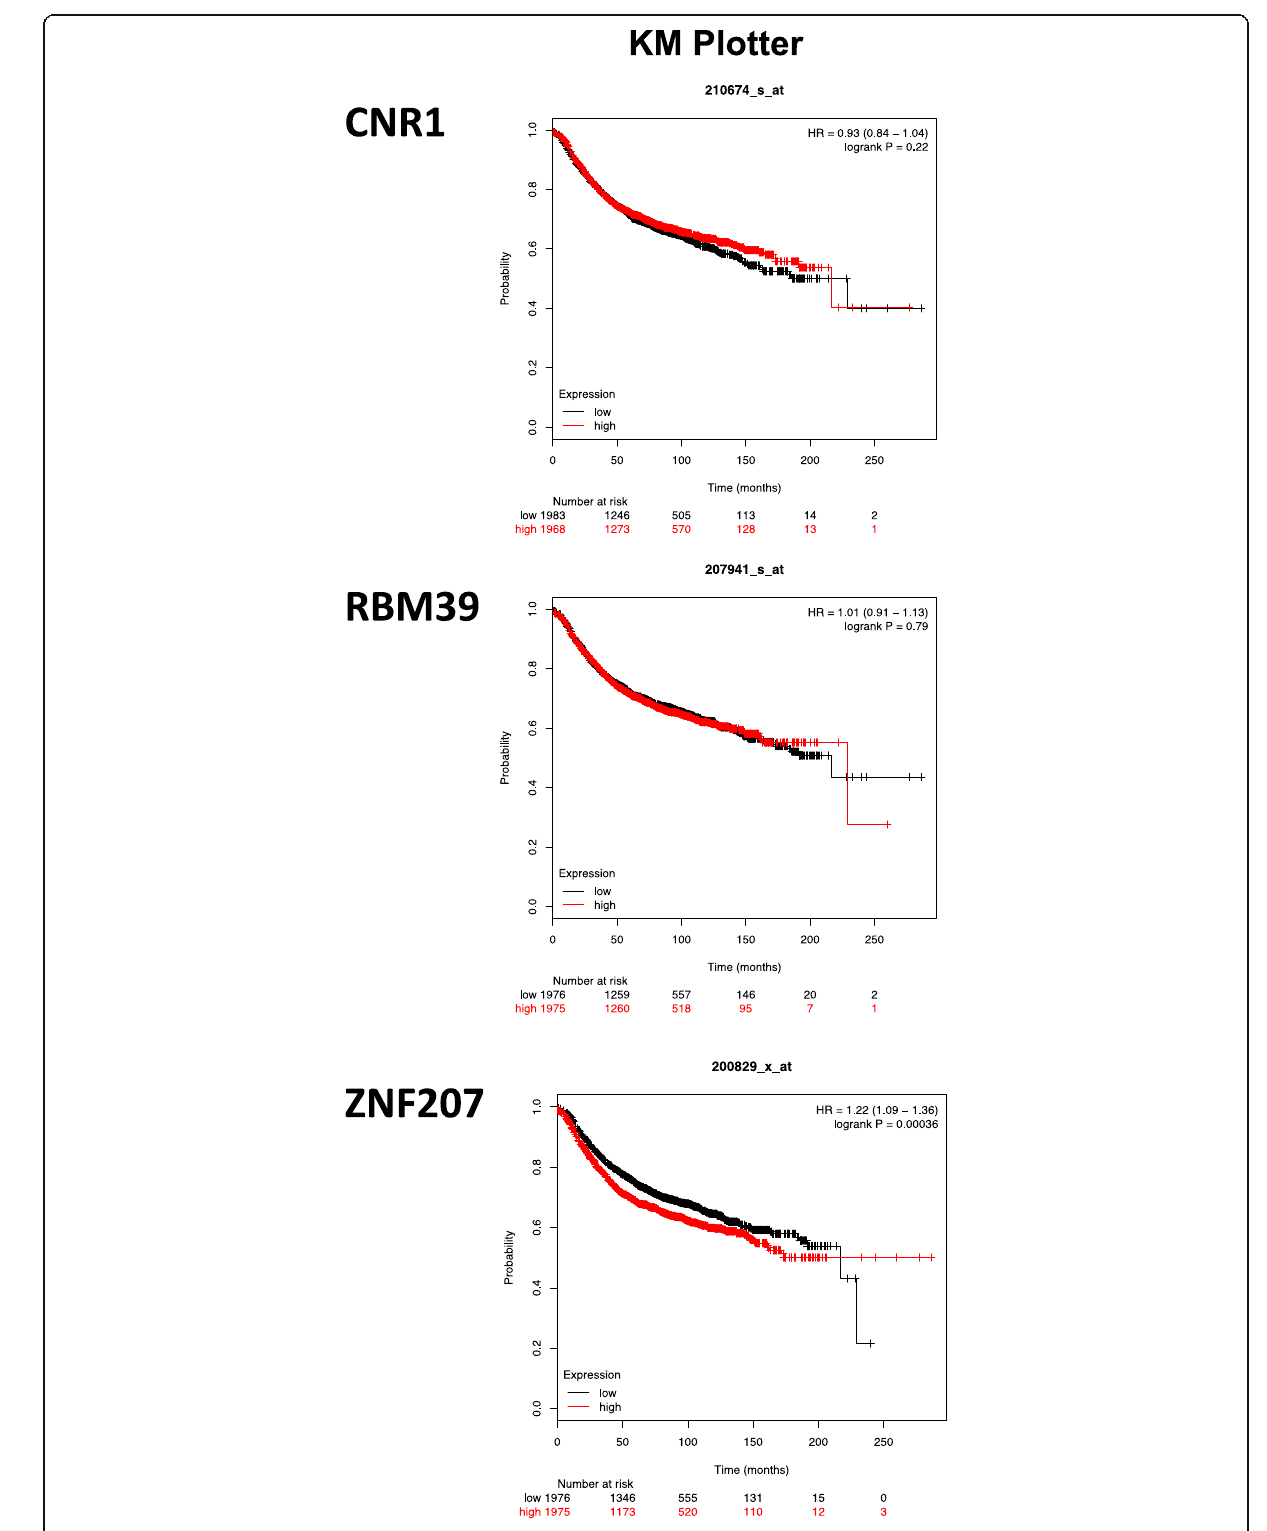
Fig. 2 Overall survival curve of breast cancer patients expressing CNR1, RBM39, and ZNF207, as analyzed by KM